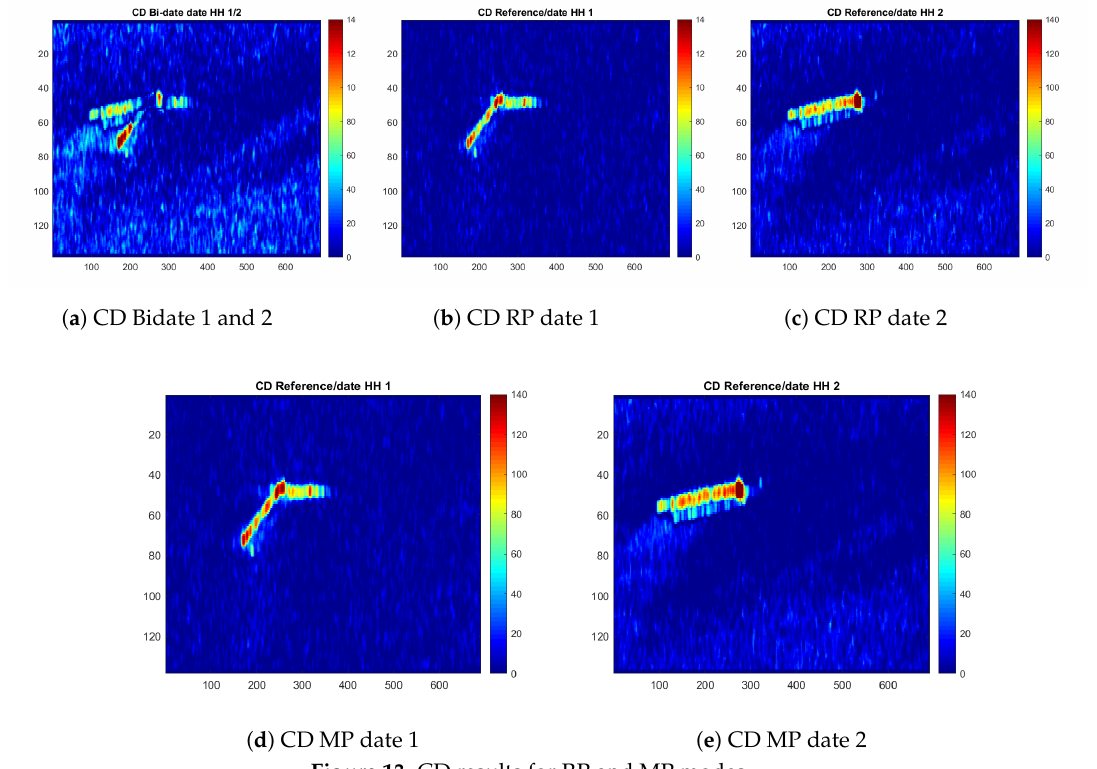
Figure 13. CD results for RP and MP